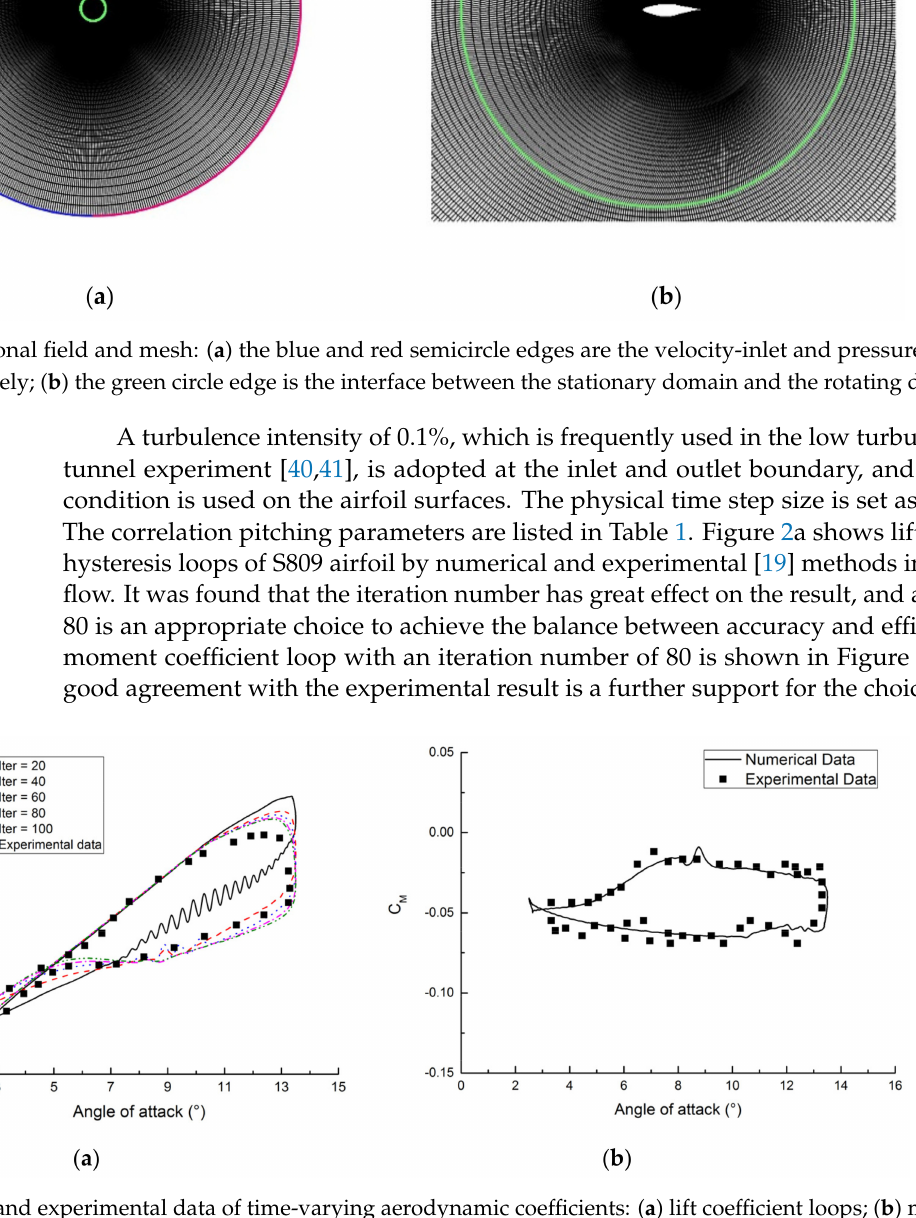
Figure 2. Numerical and experimental data of time-varying aerodynamic coefficients: ( a ) lift coefficient loops; ( b ) moment coefficient